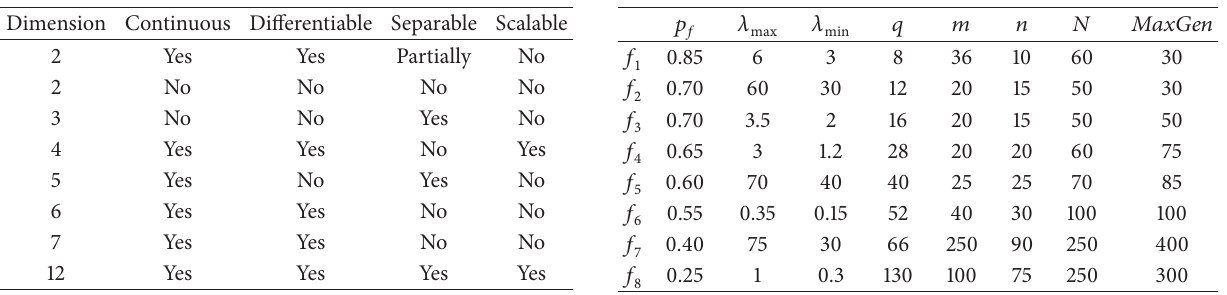
Table 2: Parameter setting for the